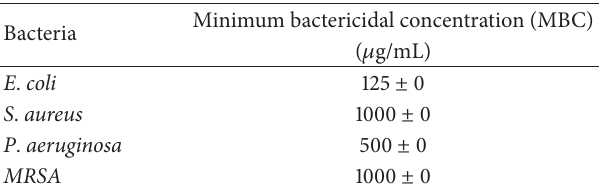
Table 1: Minimum bactericidal concentration (MBC) against 5 bac-